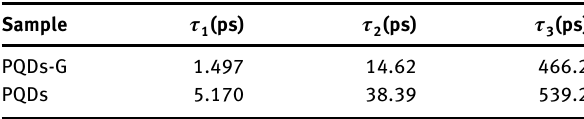
Table 3: Fitting parameters of TA Decay of PQDs and PQDs-G fitted with triple exponential